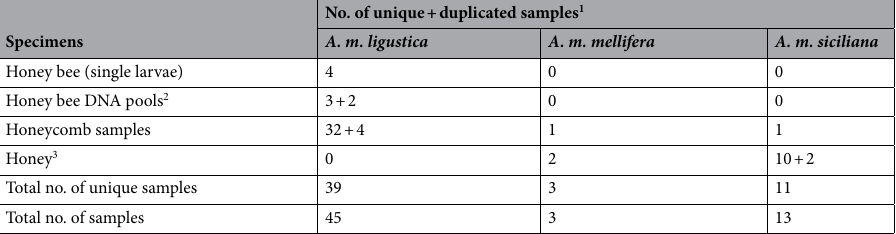
Table 1. Summary of the biological specimens (honey bee and honey samples) analysed in this study. 1 Unique samples + duplicate samples: duplicates were from DNA pools of A. m. ligustica (no. = 2), honeycomb honey samples of A. m. ligustica (no. = 4), and honey samples of A. m. siciliana (no. = 2). 2 Each DNA pool was constituted by DNA obtained from 35 different honey bees sampled from the same colony at the same time (see the text for details). 3 Undifferentiated honey samples derived from several colonies of the same